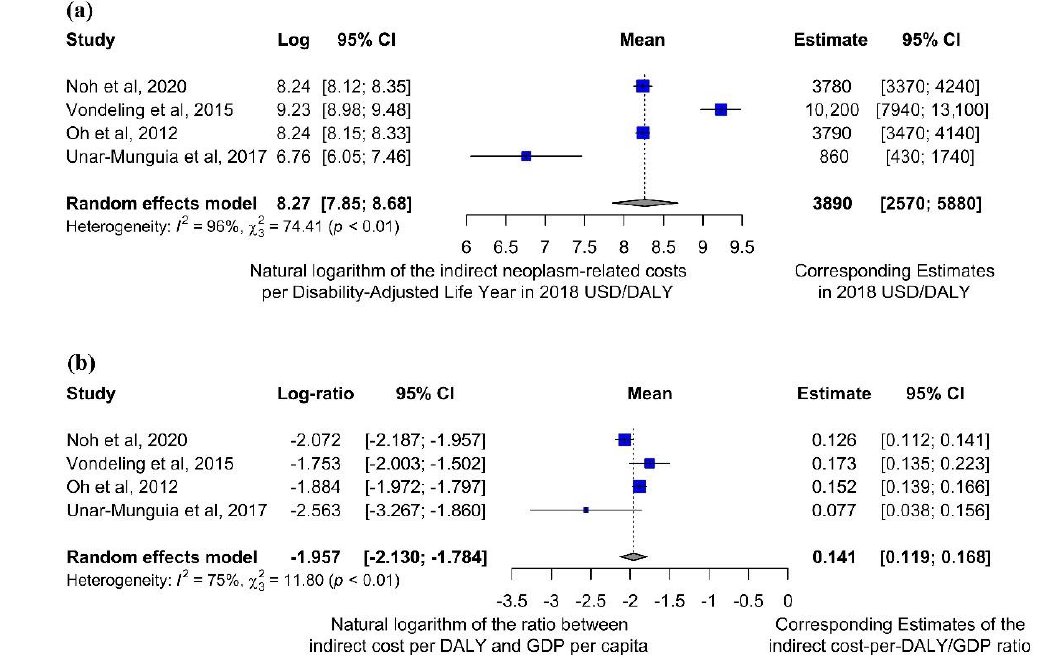
Figure 3. Forest plots for outcomes related to the ratio between indirect costs and DALYs, according to meta-analytic computations described in the Methods. A meta-analytic estimate of the average indirect cost per DALY ascribable to cancer (and its 95% CI), performed considering all studies reporting indirect cost data [32–35] ( a ). Indirect expenditures per DALY were also considered in relation to the corresponding GDP per capita ( b ). One study [31] was not included in this computation due to absence of indirect cost data.